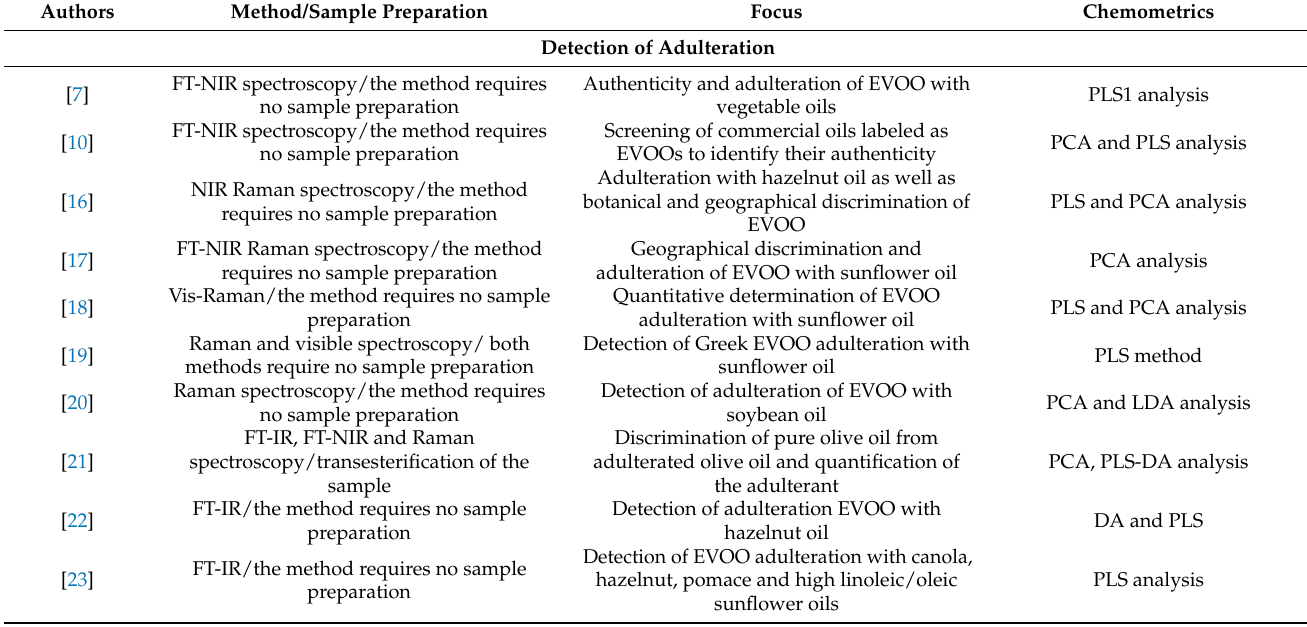
Table 1. Infrared and Raman spectroscopic methods used to evaluate authenticity of EVOO and VOO.